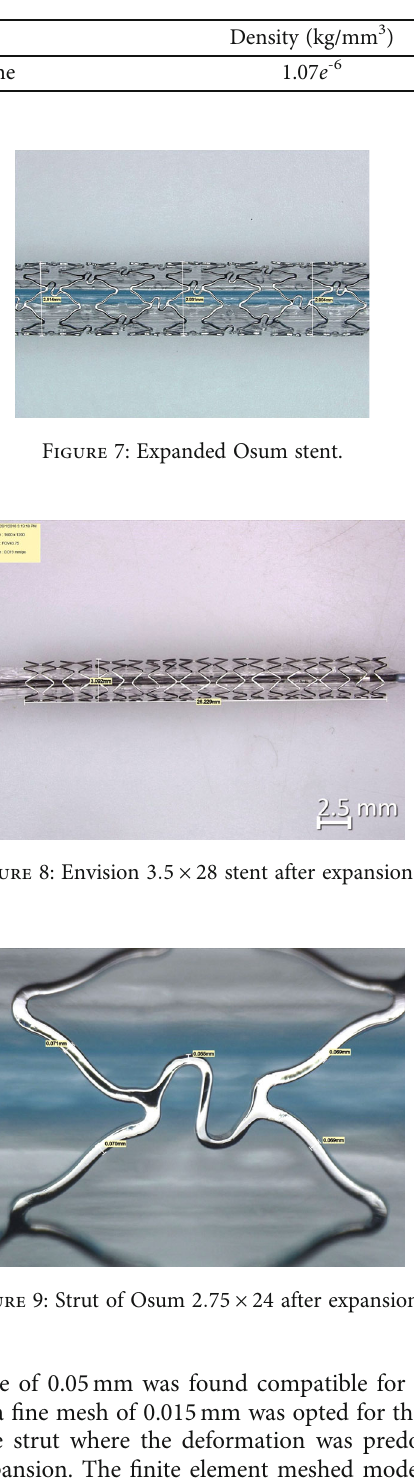
Table 2: Material properties of balloon.